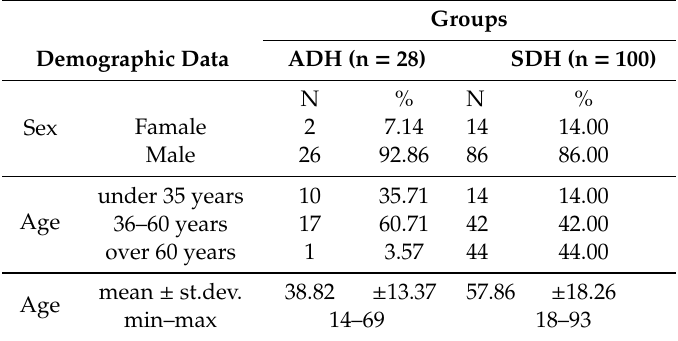
Table 1. Demographic data.